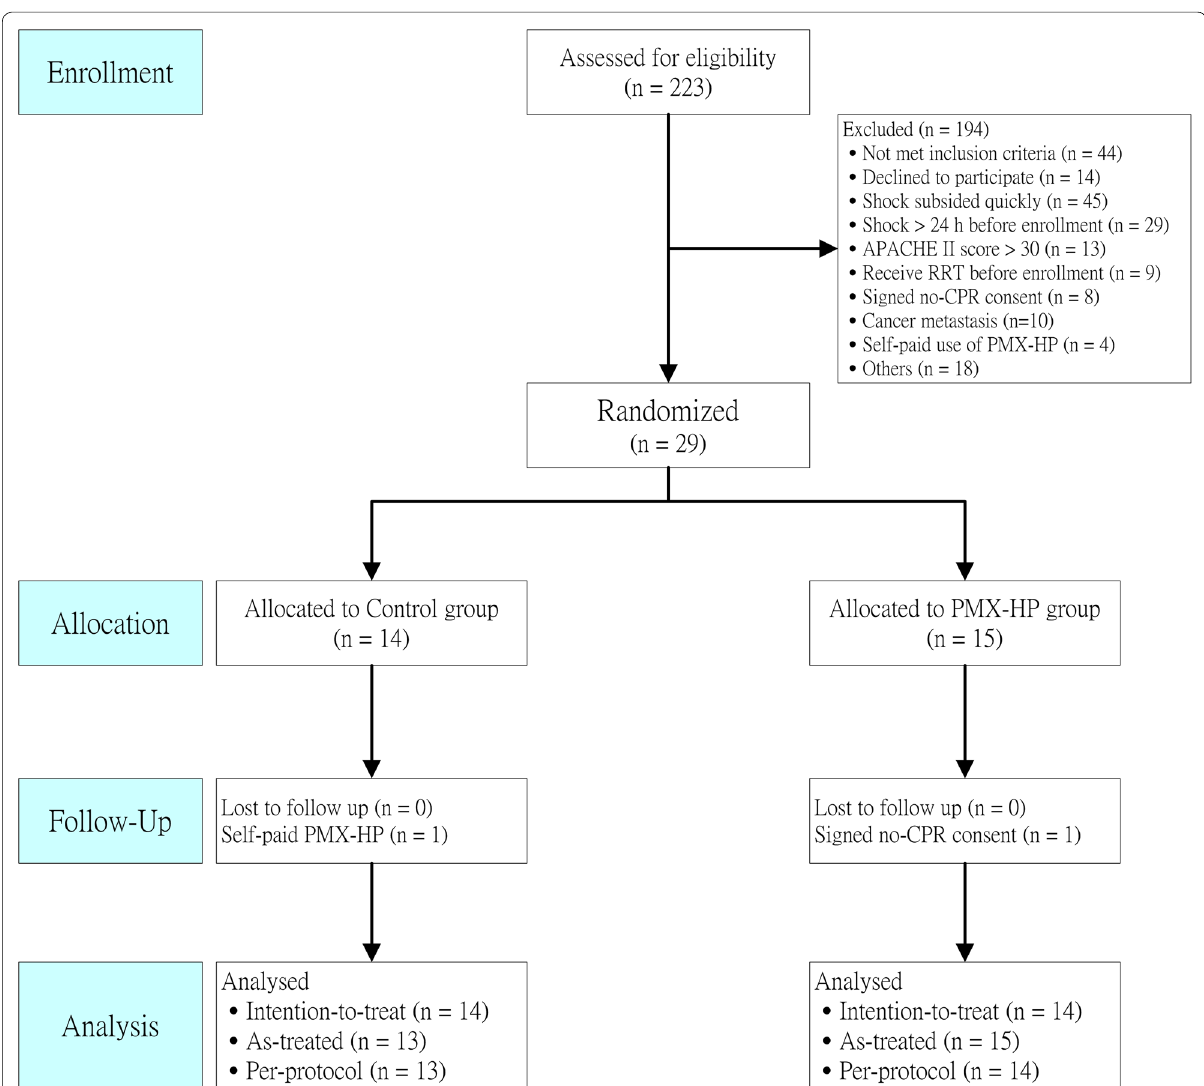
Fig. 1 Consort flowchart of patient enrollment. APACHE acute physiology and chronic health evaluation, CPR cardiopulmonary resuscitation, PMX ‑ HP polymyxin B